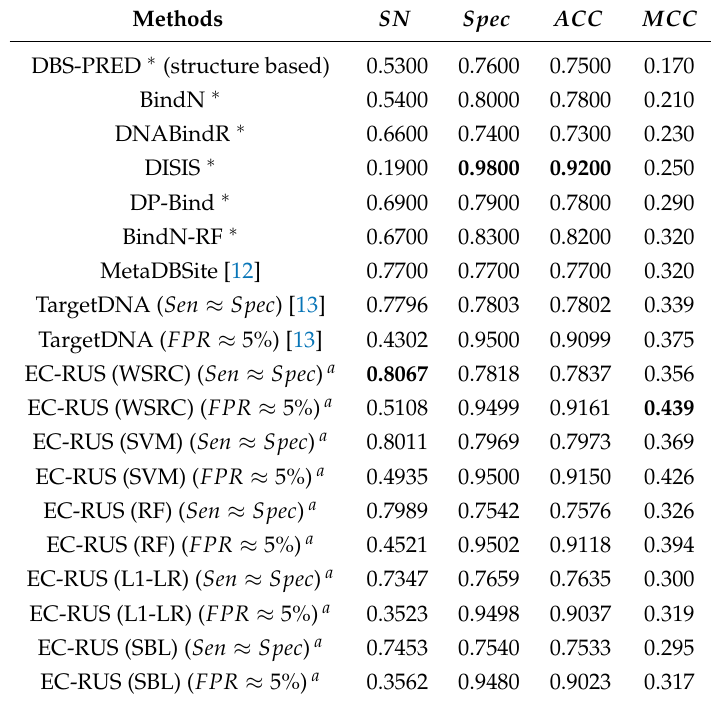
Table 5. Comparison of the prediction performance between the proposed method and some state-of-the-art works on PDNA-316